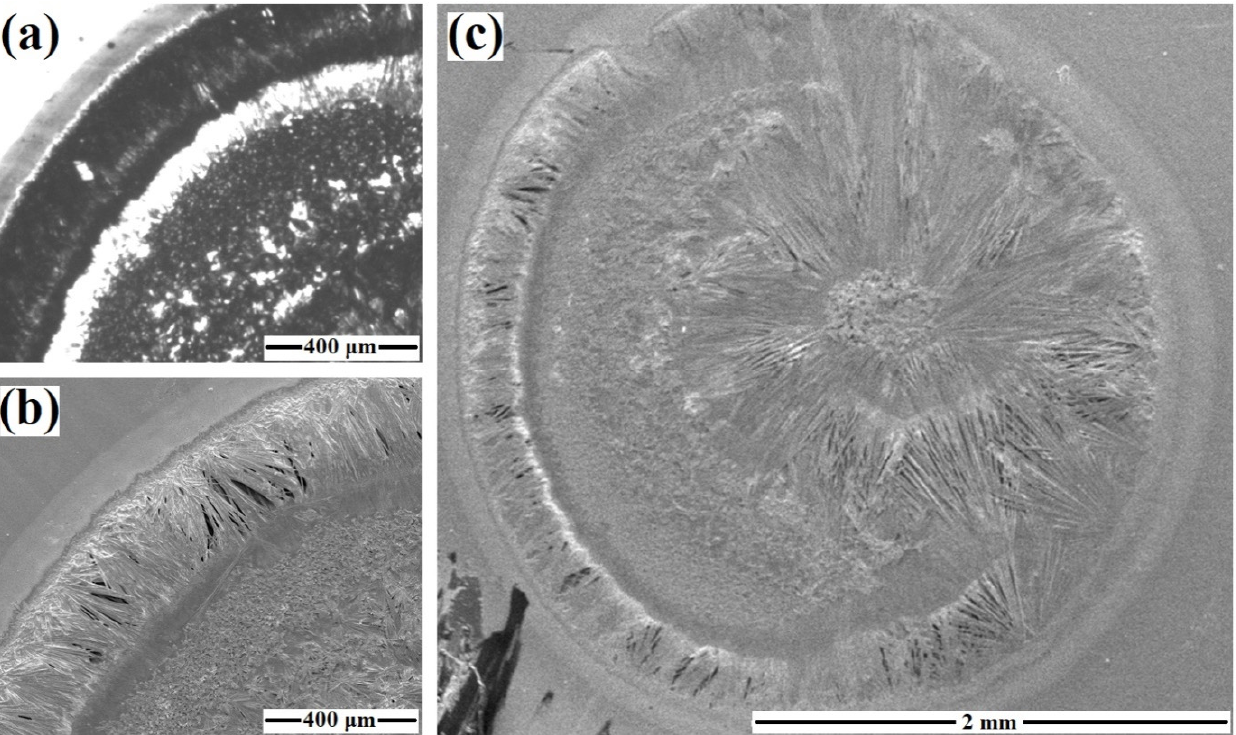
Figure 4. Top-view ( a ) optical microscopic image and ( b , c ) SEM image of a perovskite droplet on the m-TiO 2 layer demonstrating the coffee-ring effect.